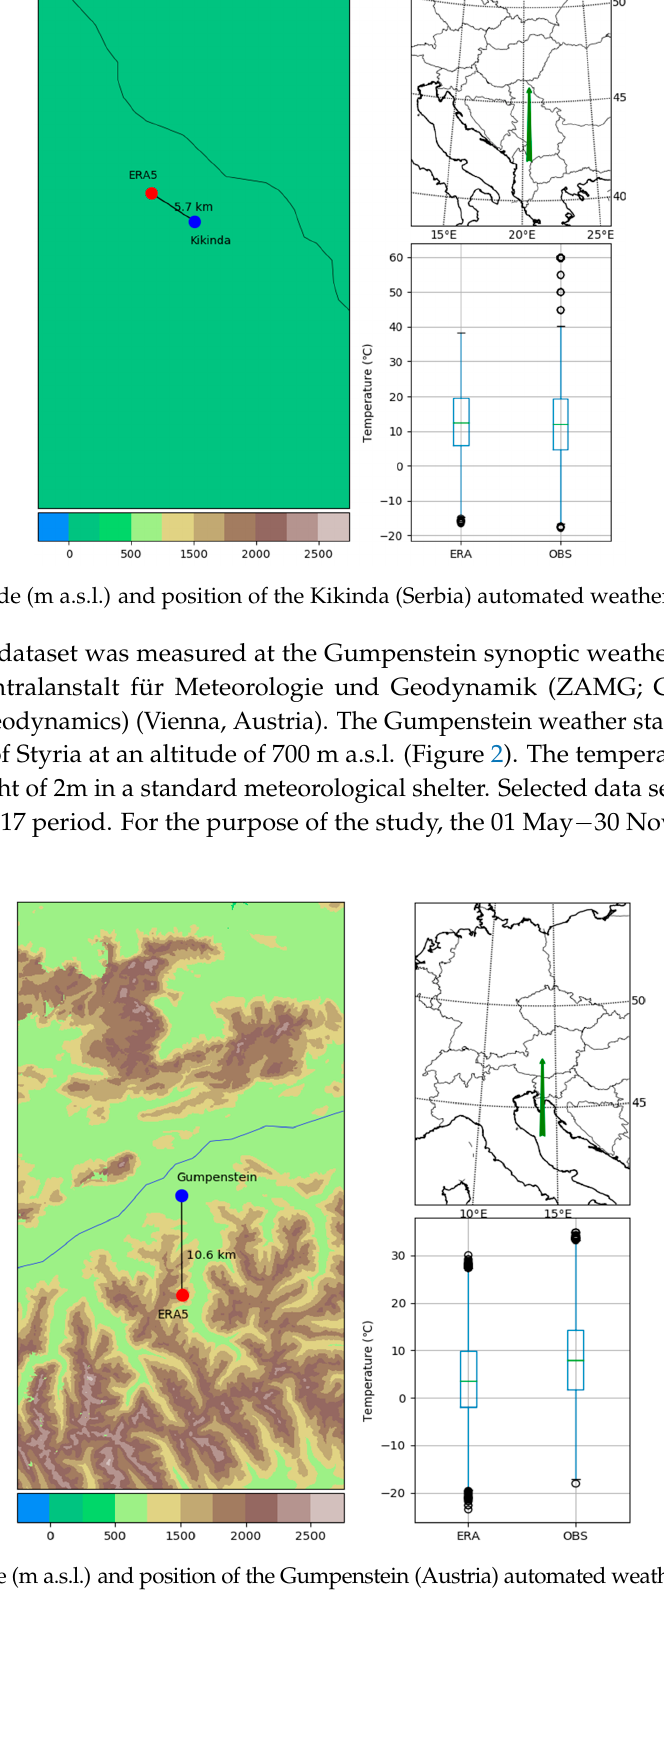
Figure 3. Altitude (m a.s.l.) and position of the el-Bahariya oasis (Egypt) automated weather station (AWS).